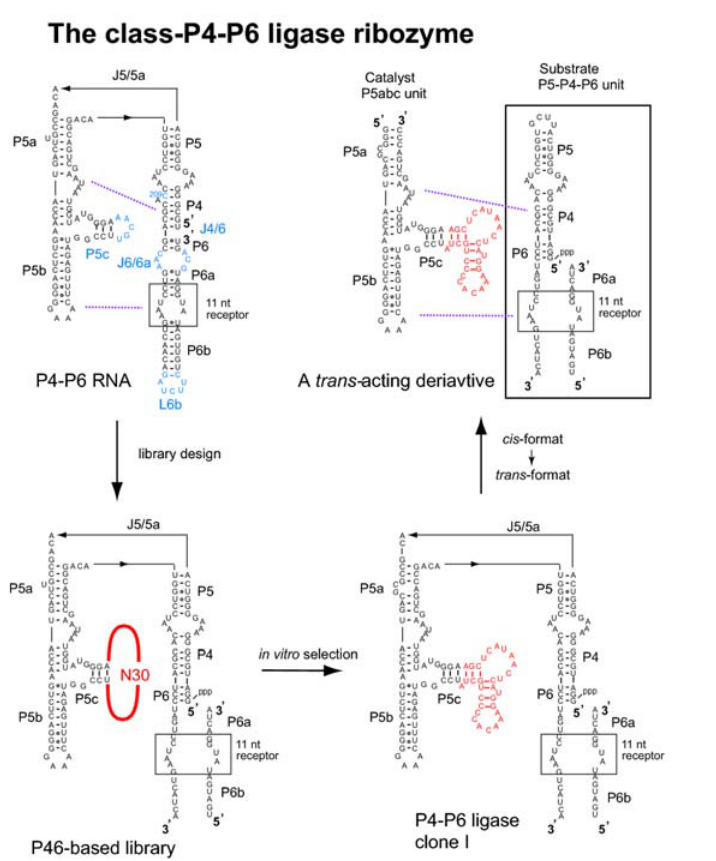
Figure 4. Design, generation, and modification of the class-P4-P6 ligase ribozyme. (upper left) Secondary structure of the P4-P6 RNA consisting of the P5-P4-P6 domain and the P5abc subdomain. Regions modified for library construction are shown in blue (P5c, C209, J4/6, J6/6a, and L6b). Purple broken lines indicate tertiary interactions between P5-P4-P6 and P5abc. (lower left) Secondary structure of an RNA library derived from the P4-P6 RNA. (lower right) A catalytically active clone (clone-1) isolated from the library. (upper right) A bimolecular derivative of the clone-1 consisting of the catalyst P5abc unit and the substrate P5-P4-P6